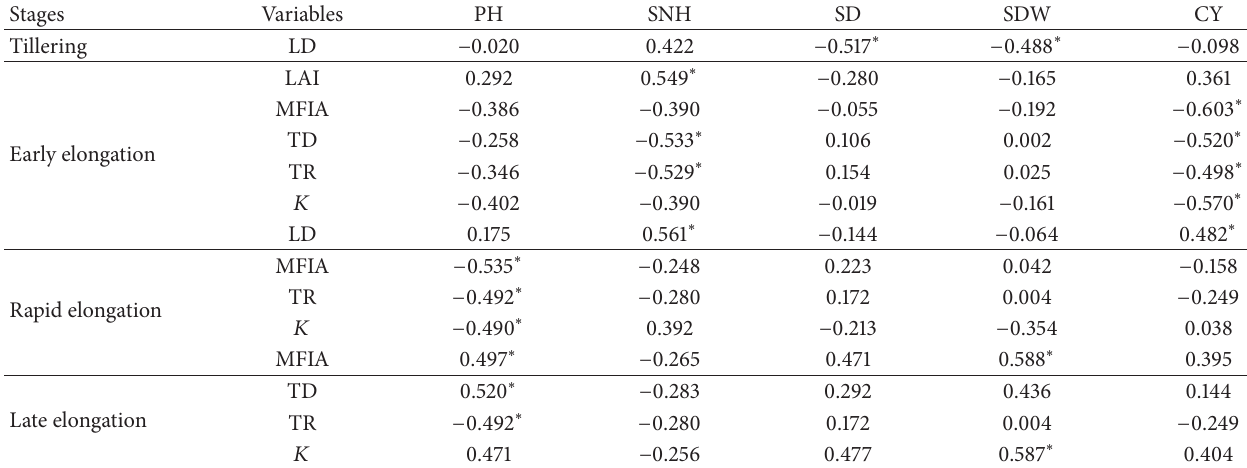
Table 8: Correlation matrix of main economic traits and canopy trait in